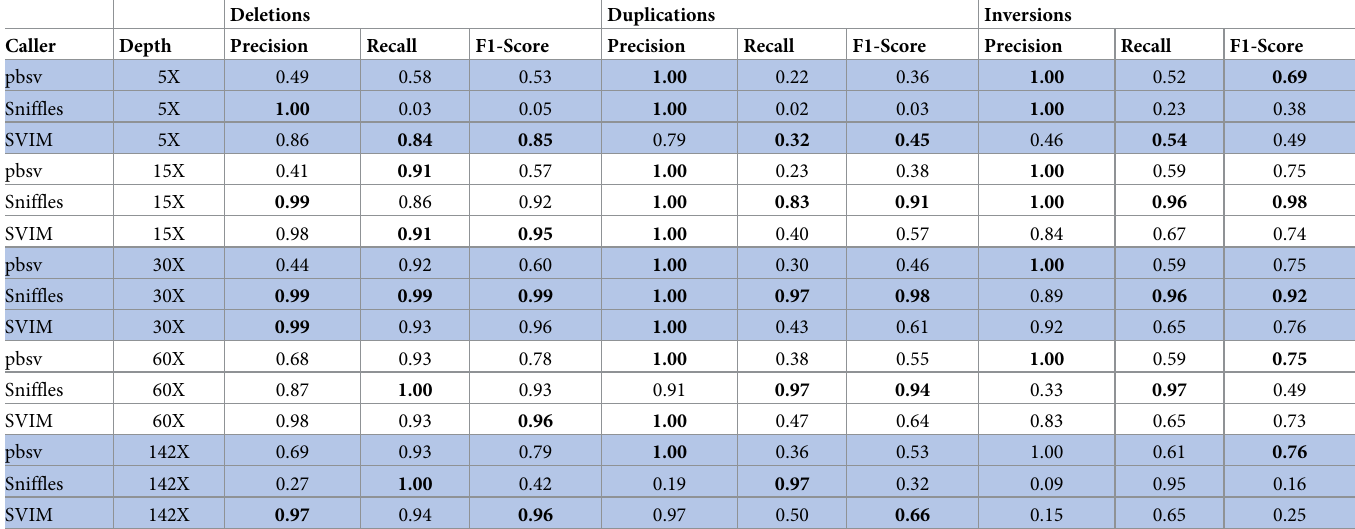
Table 3. Performance of long-read structural variant callers on simulated